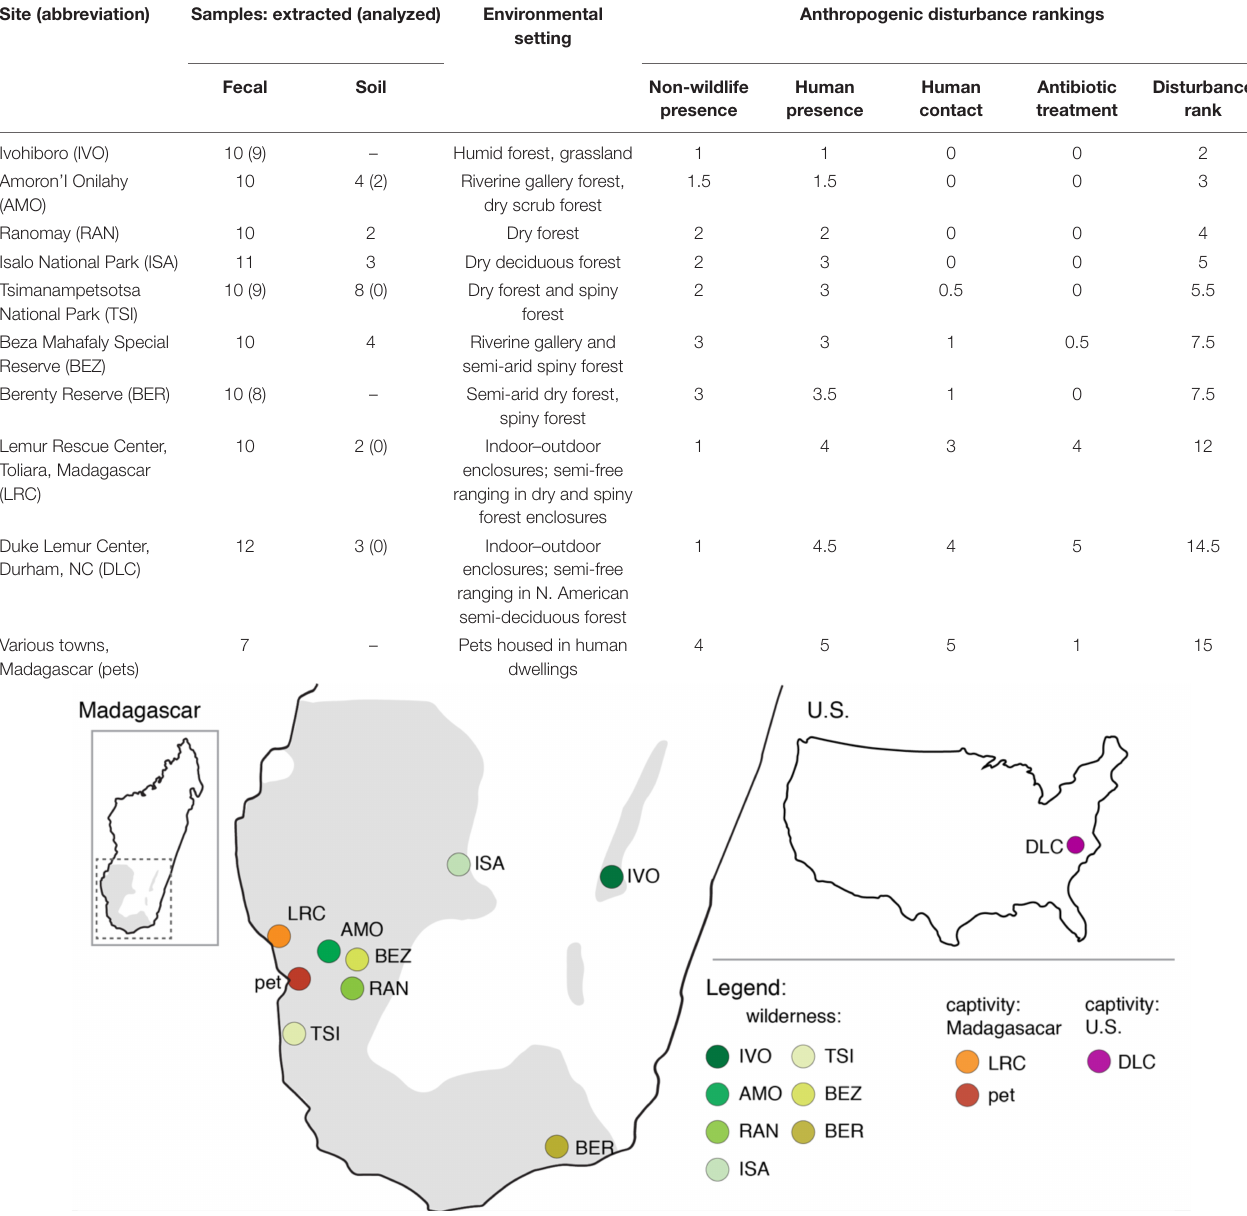
TABLE 1 | Descriptions of sites, lemur fecal and soil samples, and disturbance ranks. Site (abbreviation) Samples: extracted